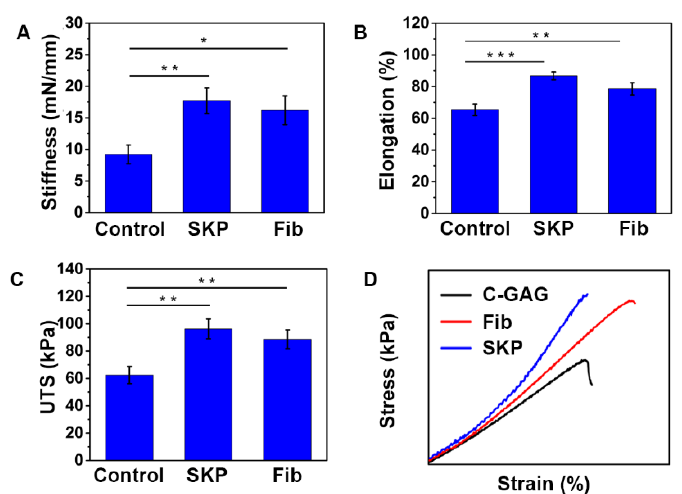
Figure 4. Biomechanical properties of SKP-populated C-GAG matrixes. The biomechanical properties of acellular and SKPs or dermal fibroblast-populated C-GAG matrixes were assessed after 10 days of culture using a tensile tester. ( A ) Stiffness. ( B ) Elongation. ( C ) UTS. ( D ) Representative stress–strain curve of C-GAG matrixes. The values represent the Mean ± SD ( n = 6). * p < 0.05; ** p < 0.01; *** p < 0.001 .